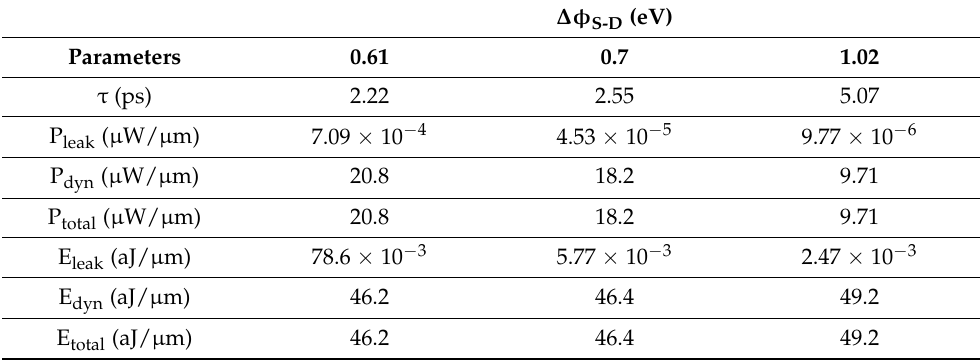
Table 2. Digital performance